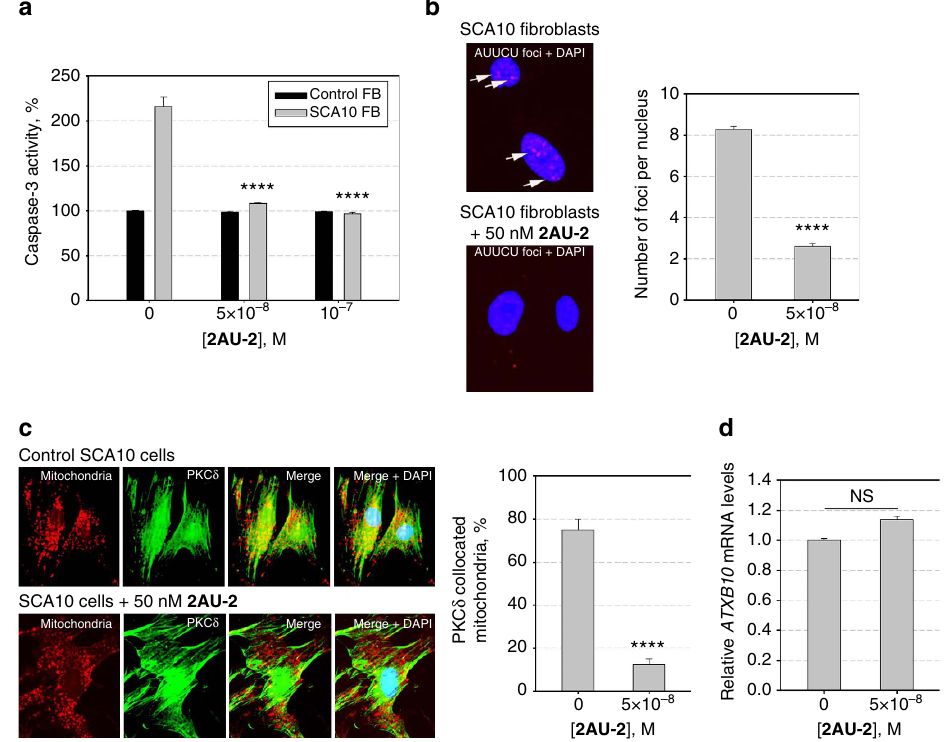
Figure 8 | Studying the bioactivity of 2AU-2 in SCA10 patient-derived fibroblasts. ( a ) Relative caspase-3 activities in normal and SCA10 fibroblasts before and after treatment with compound 2AU-2 . Caspase-3 in SCA10 was reduced to normal levels when cells were treated with 50nM compound. ( b ) Confocal images showing r(AUUCU) exp -containing nuclear foci in SCA10 cells without treatment (left, top) and after treatment with 50nM 2AU-2 (left, bottom). Quantification of the number of r(AUUCU) exp -containing nuclear foci (right) in treated and untreated cells. ( c ) confocal images showing mitochondrial translocation of PKC d after treatment with 50nM 2AU-2 (left, bottom) compared with control, untreated SCA10 cells (left, top). Quantification of PKC d collocated to mitochondria in treated and untreated cells (right). ( d ) Real-time RT–PCR analysis of ATXN10 mRNA expression levels after treatment with 2AU-2 . The amount of mRNA was normalized relative to GAPDH mRNA. Values are reported as the mean ± s.e. ( n ¼ 6). **** P o 0.0001 and ‘ns’ denotes P 4 0.05, as compared with the untreated sample with a two-tailed Student t